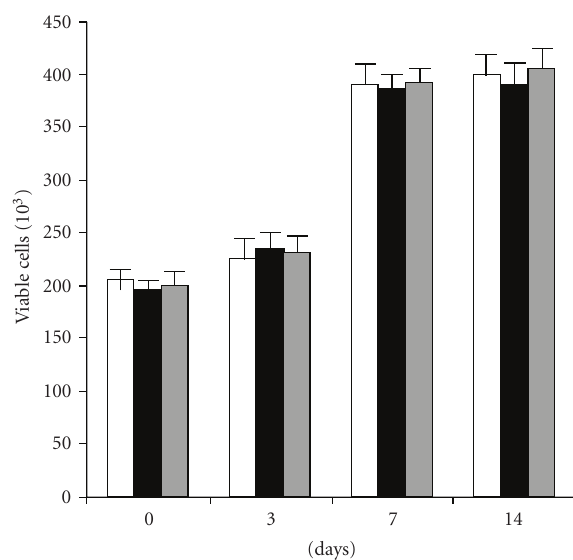
Figure 2: Cell viability during repeated, DOTAP-mediated trans- fection rounds in di ff erentiating HSCs . Freshly isolated HSCs were induced to di ff erentiate into immunogenic dendritic cells as described in the Materials and Methods. Immediately after treatment, cultures were split into two cell populations, of which one, used as the control, was grown in absence of manipulations ( white bars ), while the other was subjected to two and three DOTAP-based, scrambled siRNA transfection rounds performed at day 0 and day 3 ( black bars ), and day 0, day 3 and day 9 ( grey bars ). Cell viability was monitored by trypan blue staining at di ff erent time points as